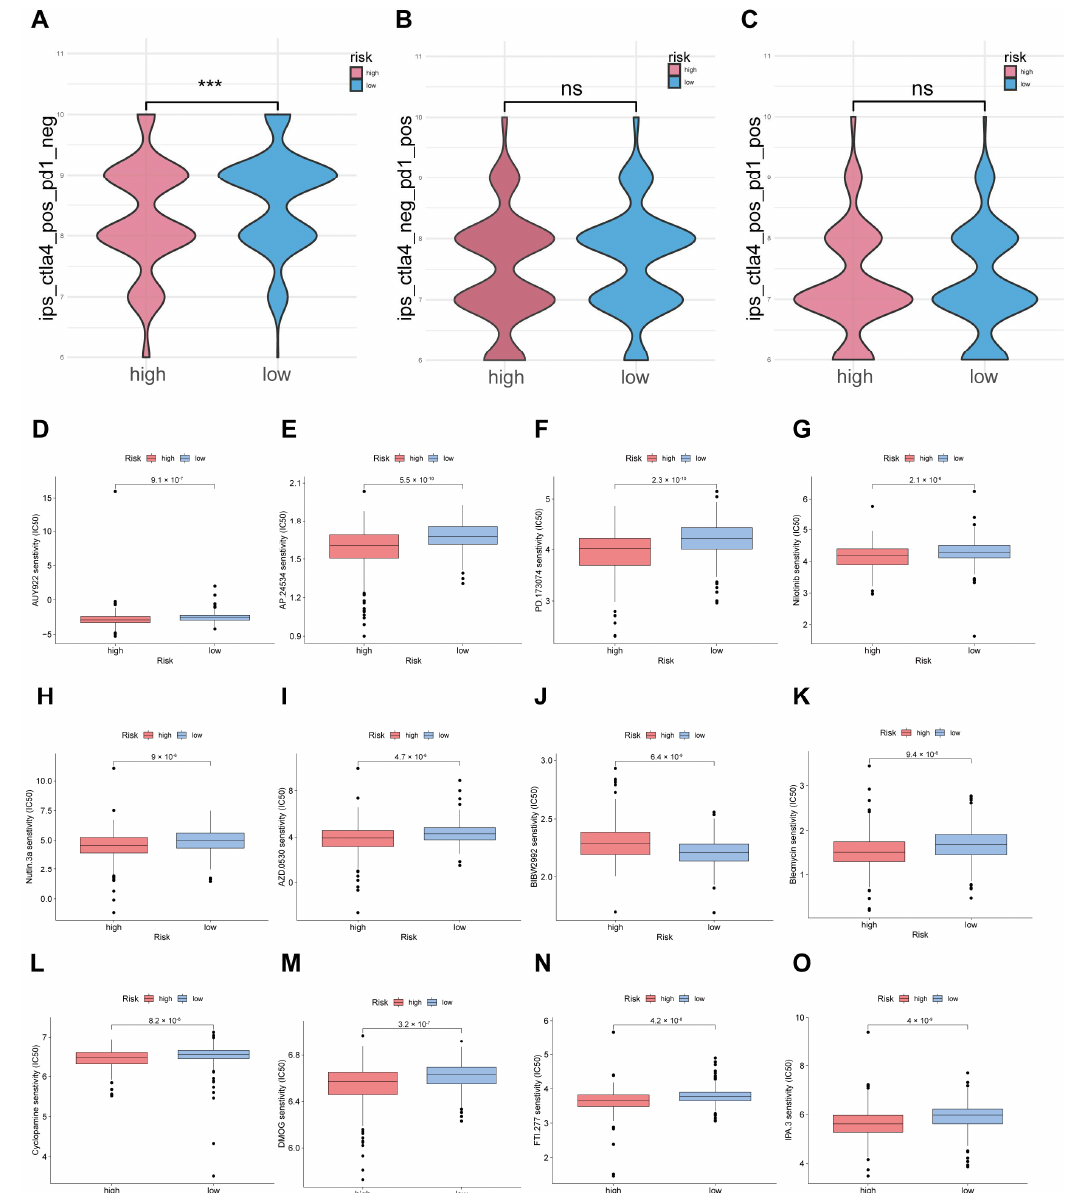
Figure 8. Immunotherapy and drug sensitivity prediction in risk groups of CRC patients. ( A – C ) The association between IPS and the risk score of CRC patients based on the TCGA database. ( A ) CTLA4+ and PD1 − . ( B ) CTLA4 − and PD1+ cells. ( C ) CTLA4+ and PD1+ cells. ( D – O ) Boxplot